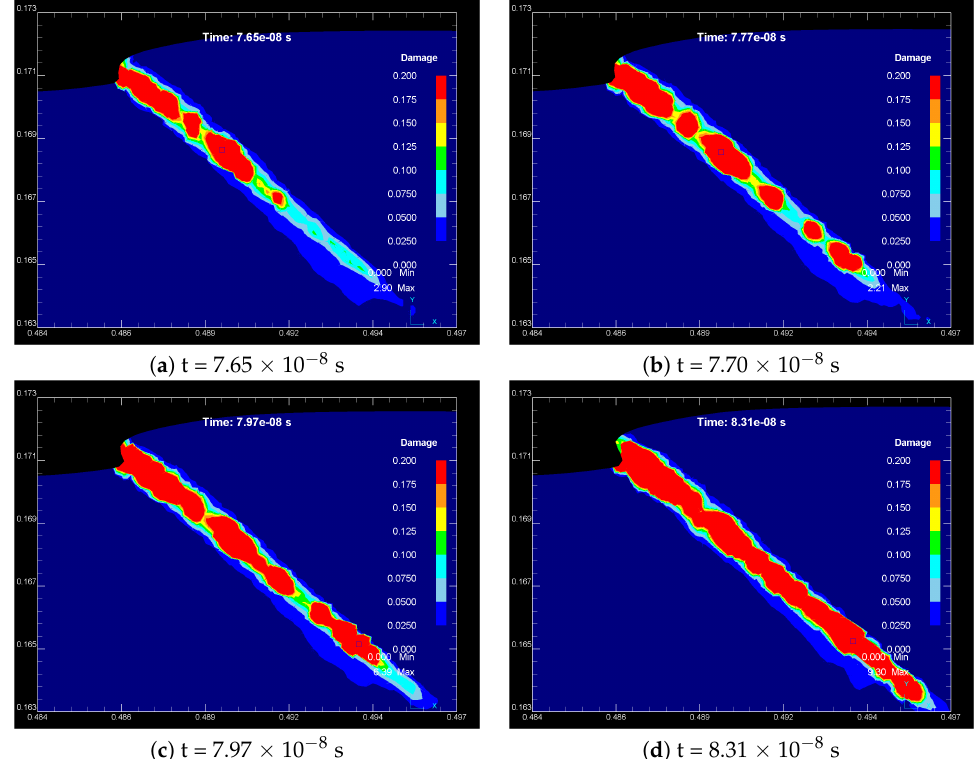
Figure 9. Isosurfaces of of the integral D revealing the discontinuous degradation and coalescence mechanism inside ASB; minimum element size h ≈ 0.2 µ m; simulations using the NCL damage criterion (CDV = 0.2); cutting conditions: v = 60 m/s, feed = 0.01 mm/rev, rake angle γ = 0 ◦ ; snapshots are taken at: ( a ) t = 7.65 × 10 − 8 s, ( b ) t = 7.70 × 10 − 8 s, ( c ) t = 7.97 × 10 − 8 s, and ( d ) t = 8.31 × 10 − 8